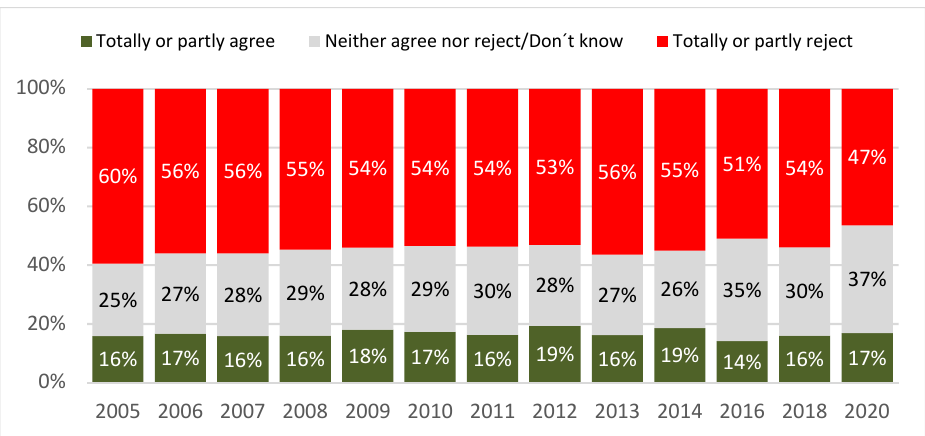
Figure 12. Negative statement about responsibility at work: Swedes have greater responsibility towards their job compared to people with a foreign background.